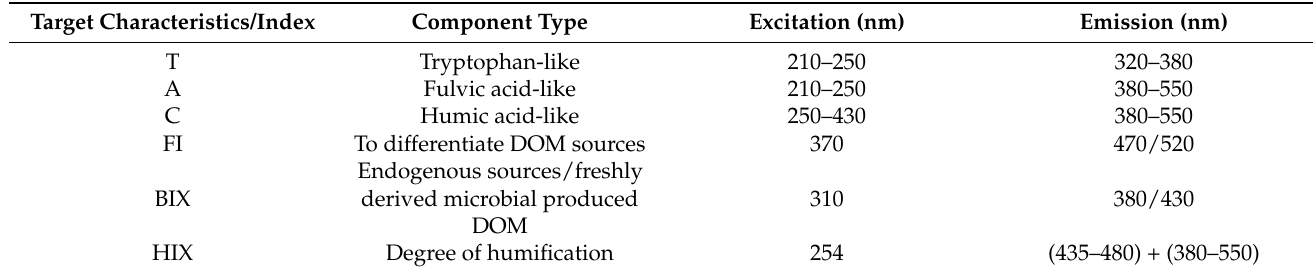
Table 5. Compositions and indices of fluorescence DOM of SR and